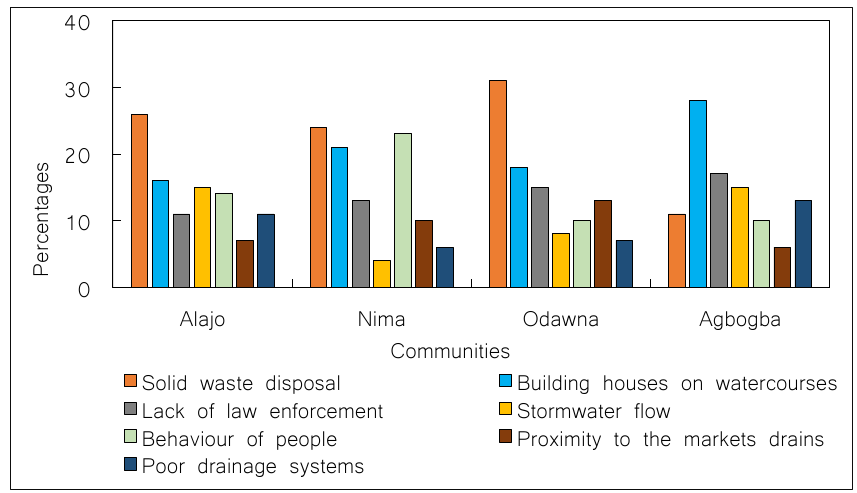
Figure 6. Contributing factors influencing flooding in the Odaw catchment. Data source: based on primary data collection, using household surveys in the Odaw River catchment in Ghana, in April 2019.